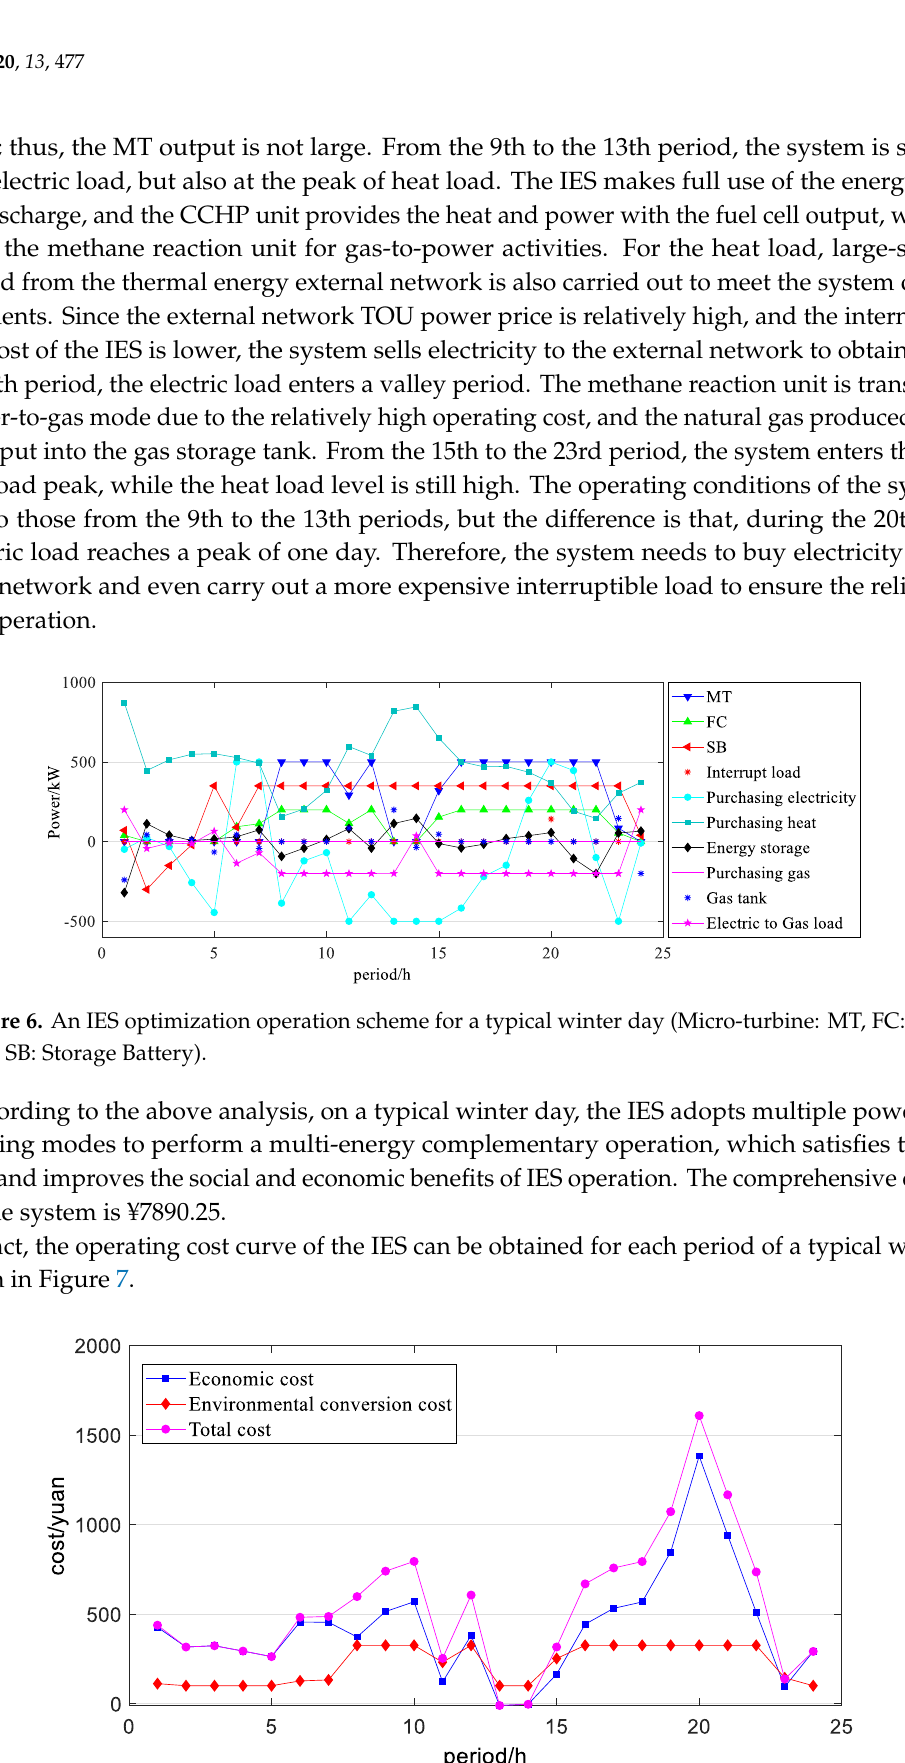
Figure 8. Optimal operation scheme of the IES for a typical summer day (Micro-turbine: MT, FC: Fuel Cell, SB: Storage Battery). It can be seen in Figure 8 that the principle of the IES optimization operation scheme is basically the same as that for a typical winter day. In each peak and valley period of the system, the energy storage equipment of the power subnet, the storage device of the thermal energy subnet, and the methane reaction unit of the gas energy subnet and the gas storage tank all play a role in the peak shaving shift. Simultaneously, comparing the operation of a typical summer day and that of a typical winter day, the main differences lie in the wind power output, the level and distribution characteristics of the photovoltaic output, the load level, and the curve shape. Therefore, the minimum operating cost of a typical summer day is ¥8658.77 at a given confidence degree.